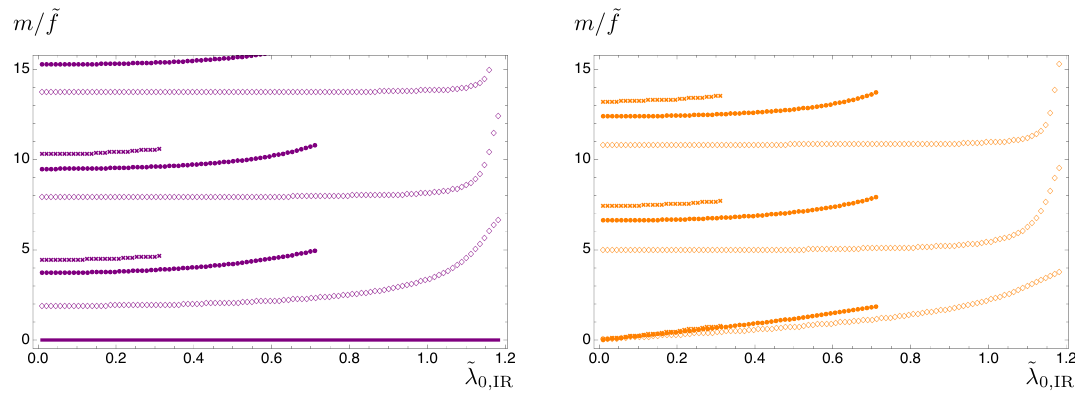
Figure 19 . Model I. Fermionic spectrum as a function of ˜ λ 0 , IR for ∆ = 2 . 5 , x F = 3 , g 5 = 8 , and ∆ R = 1 . 7 , 2 . 3 , 2 . 6 (diamonds, dots, crosses). The left and right panels correspond to imposing (+) and ( − ) IR boundary conditions, respectively. The solid line in the left panel indicates the presence of a massless state. The ratio between the UV and IR energy scales is equal to Λ UV the IR regulator r 1 = 10 − 12 in the numerics.